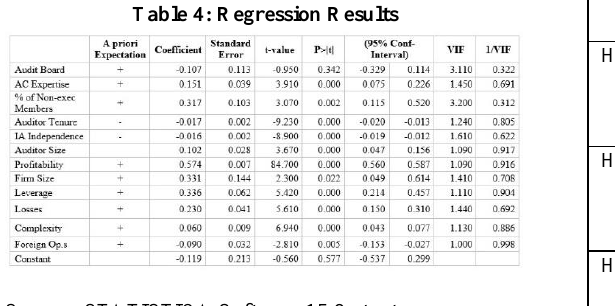
Table 4: Regression Results